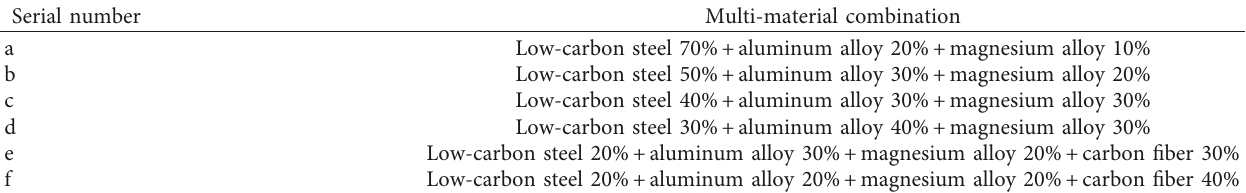
Table 4: Multi-material combination of automobile body.